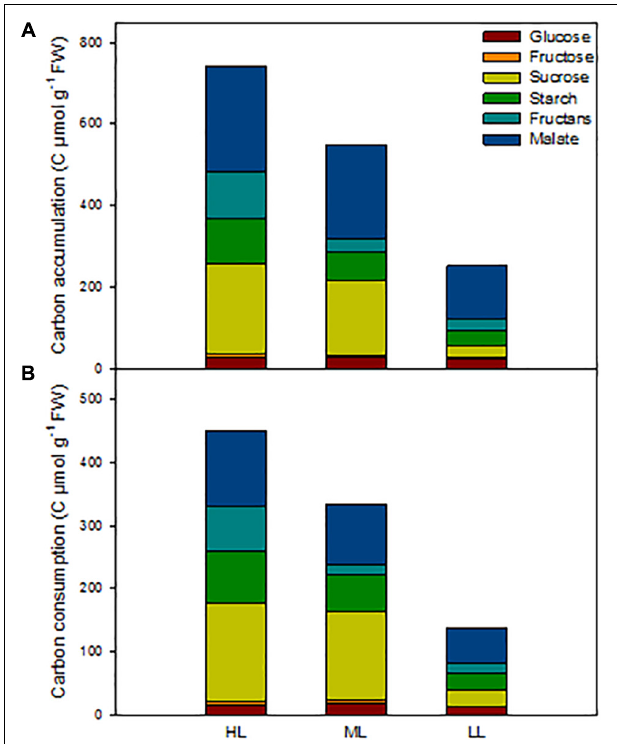
FIGURE 5 | Estimation of non-structural carbon reserves in barley cv. Propino shoots at end of the day of plants grown under three light intensities. (A) Total C amount at end of the day in whole shoots; (B) total C amount consumed during the night. Plants were grown in a 16 h:8 h light:dark photoperiod at 22 ◦ C:18 ◦ C day:night for 14 DAS under 500 µ mol photons m − 2 s − 1 (HL),